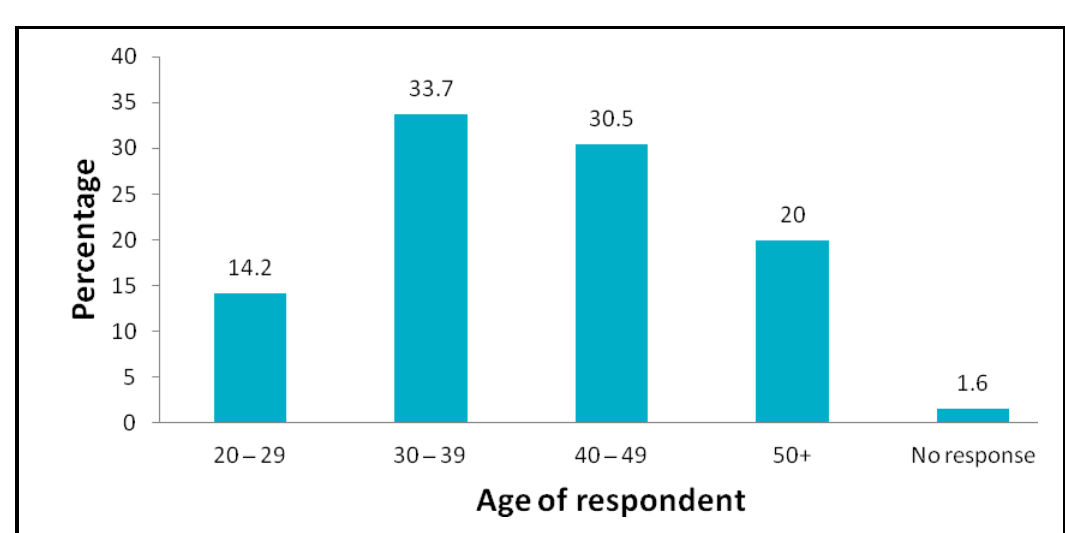
Figure 4. Gender percentage of respondents.